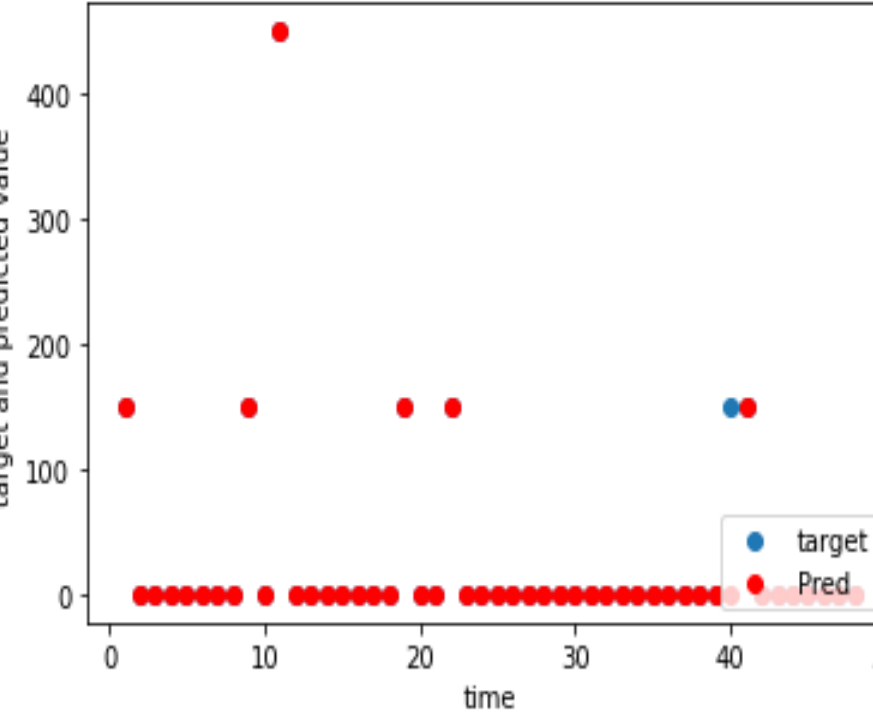
Figure 16. Charging demand prediction of a weekend for Alakaupunki.